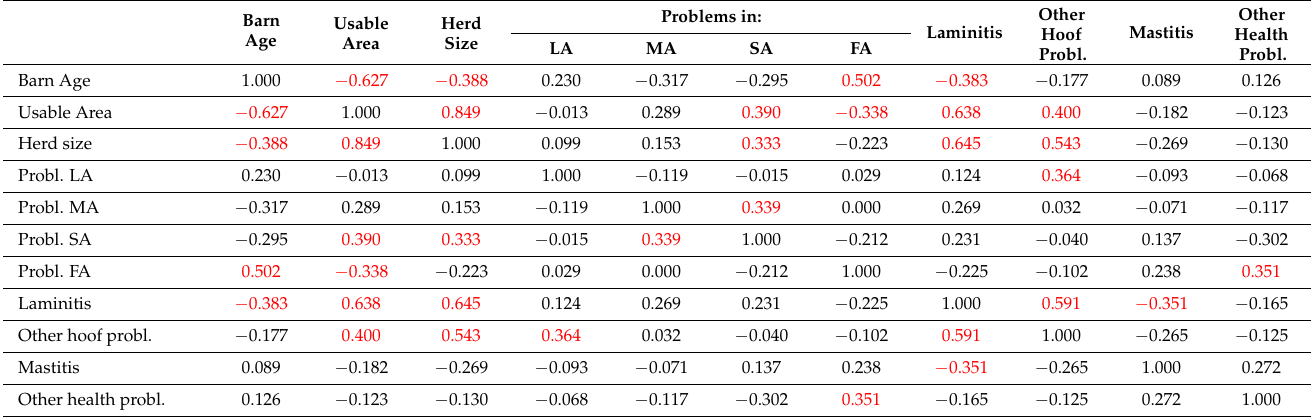
Table 6. Spearman’s rank order correlations for the main factors (variables) in the research; marked results (in red) are significant with p <